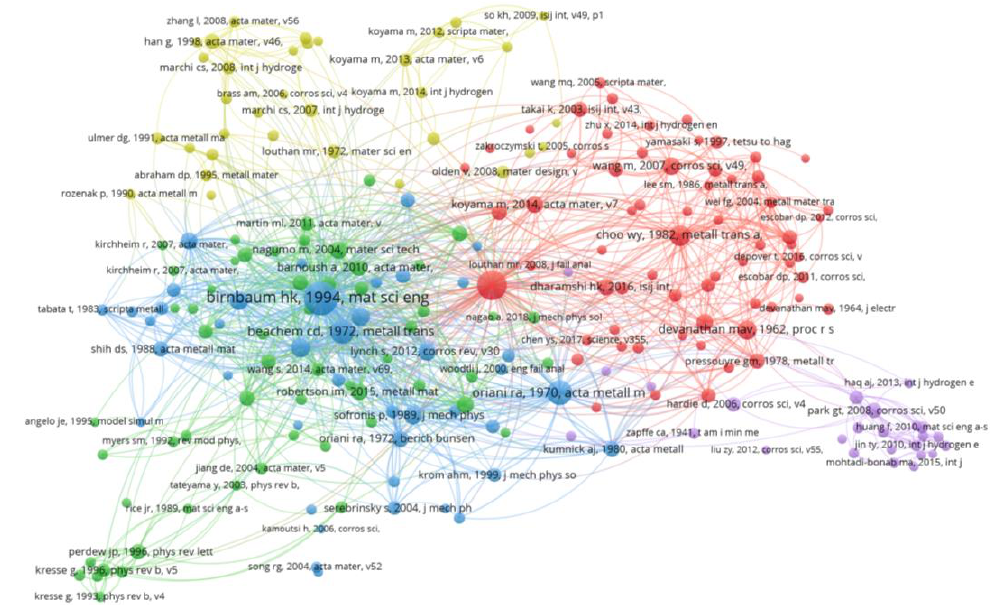
Figure 8. Co-citation network for highly cited references used in publications on hydrogen embrit- tlement.